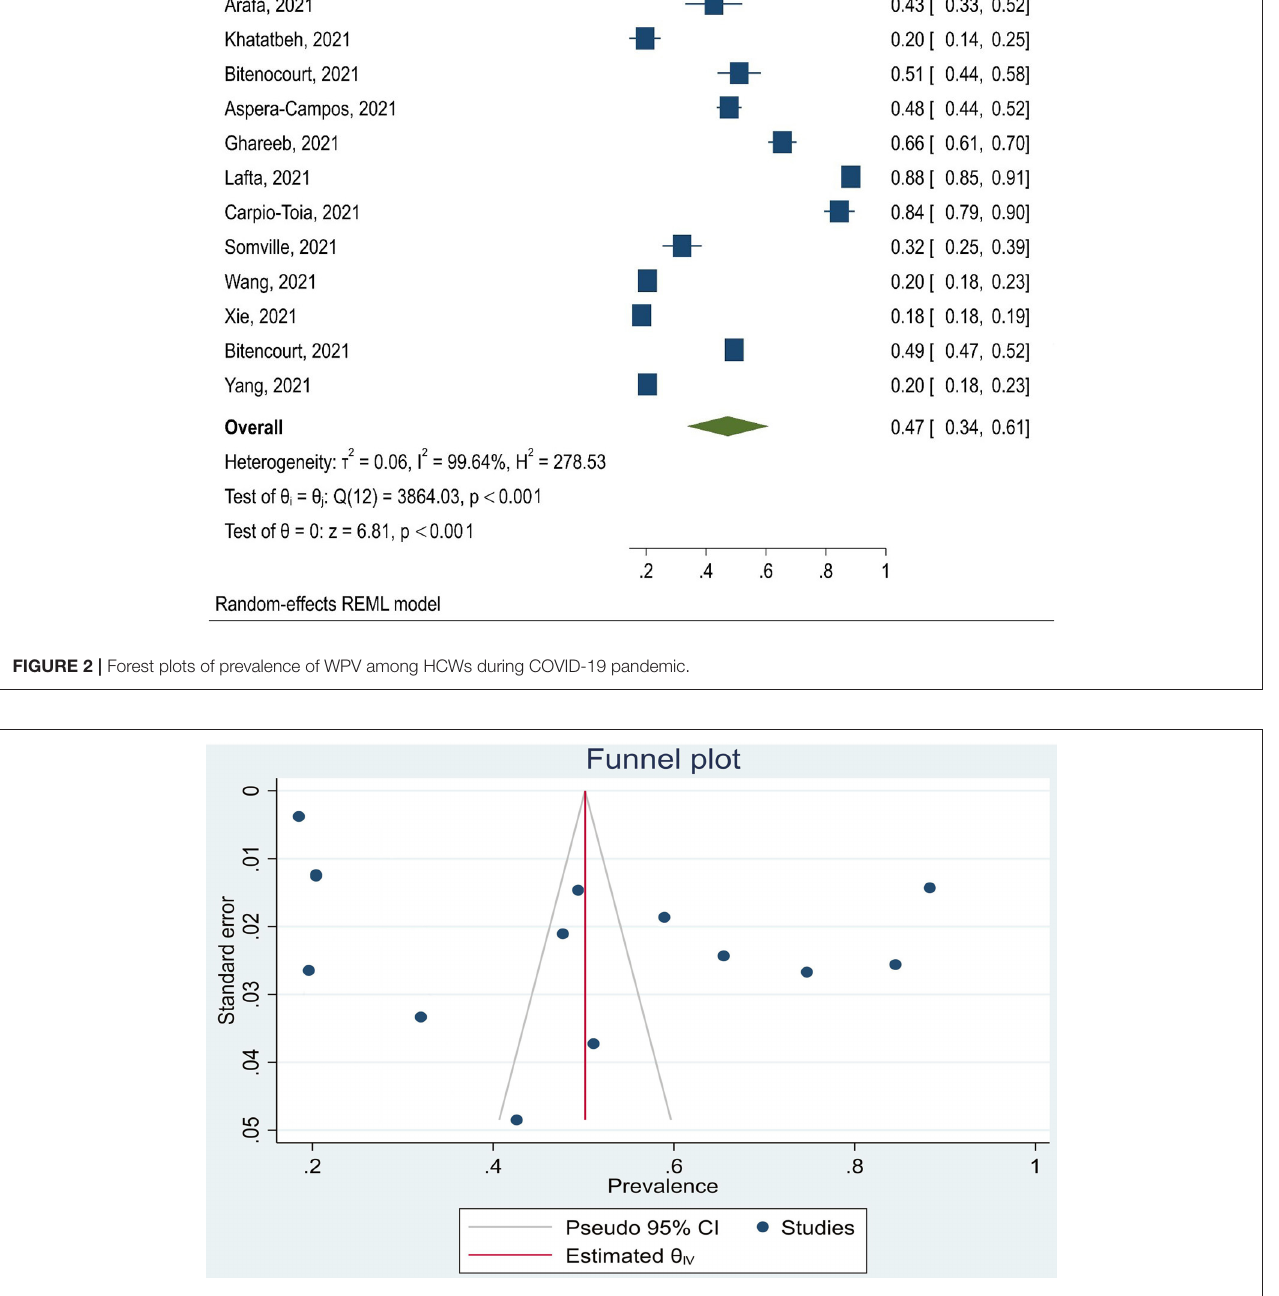
FIGURE 3 | Publication bias for total